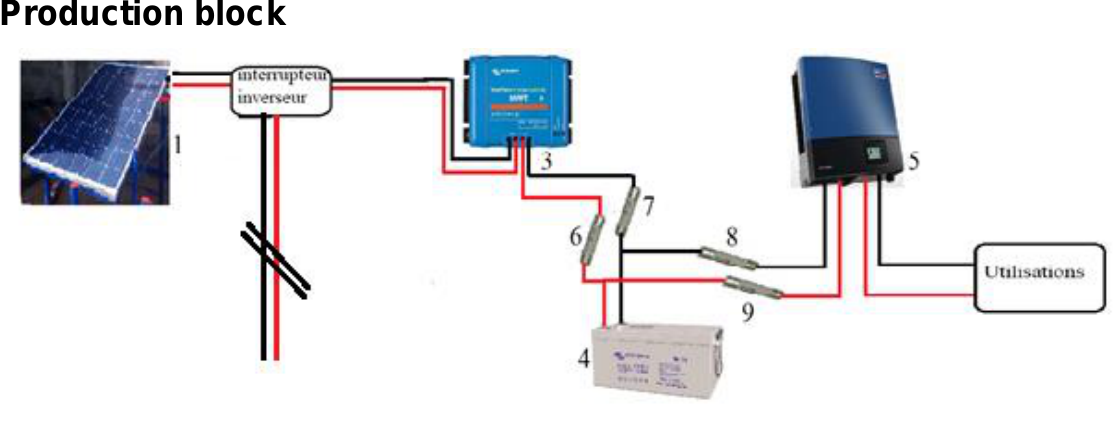
Figure 2: Production block